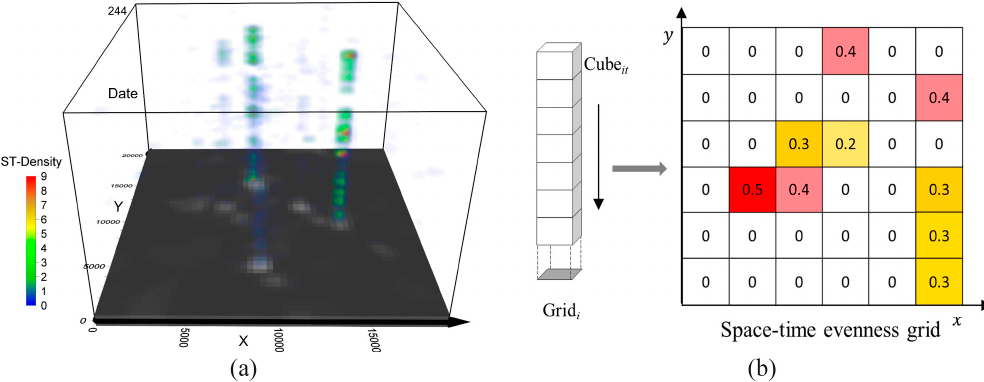
Figure 4. ( a ) An example of space ‐ time kernel density estimation (ST ‐ KDE) cube based on activity locations of #user 065. The base of the cube was the cumulative density by summing space ‐ time density on each layer together. ( b ) Schematic diagram of compressing the space ‐ time density cube into the space ‐ time evenness grid.